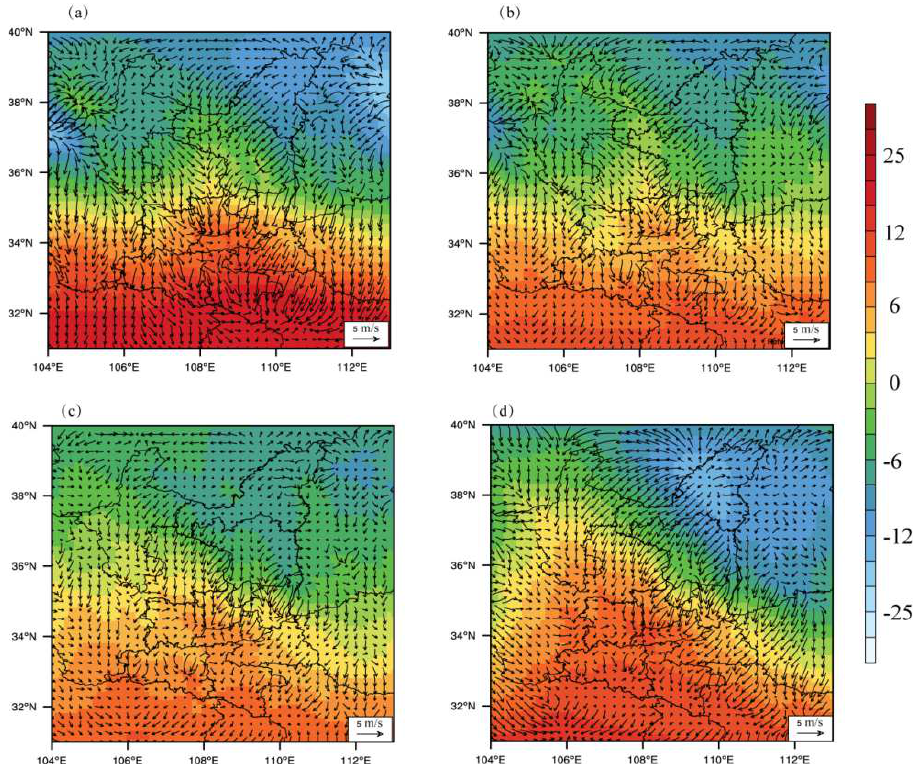
Figure 6. The convergence and divergence wind and velocity potential of 4 times in the main precipitation period of rainstorm case 3 began to be predicted at 00 UTC on 22 July 2020. ( a ) Convergent divergent wind and velocity potential at 00 UTC on 23 July. ( b ) Same as ( a ), but at 16 UTC on 23 July. ( c ) Same as ( a ), but at 12 UTC on 23 July. ( d ) The same as ( a ), but at 18 UTC on 24 July.